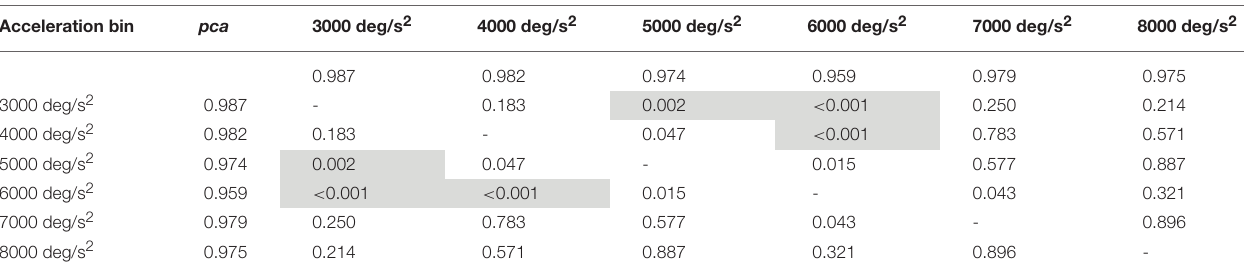
TABLE 5A | Ball sports: p -values of the multiple comparisons of pca between head acceleration bin—vertical canals. Acceleration bin